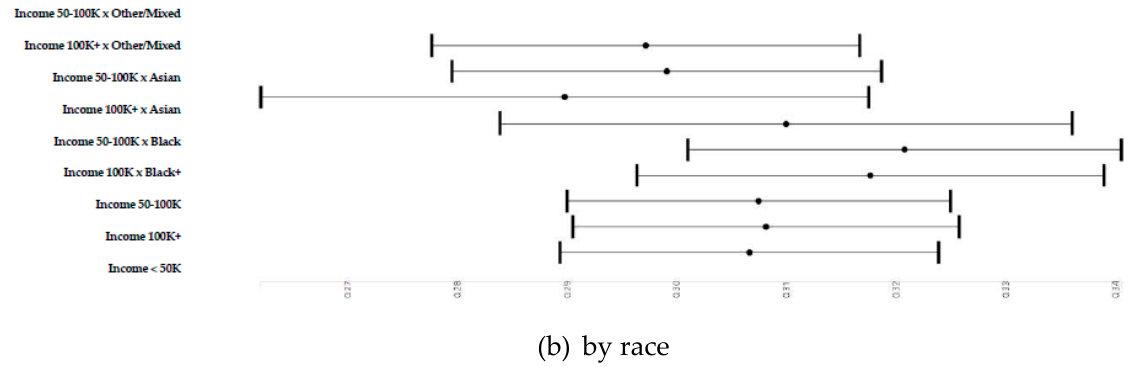
Figure 3. Association between household income and right cerebellum cortex fractional anisotropy overall and by race.